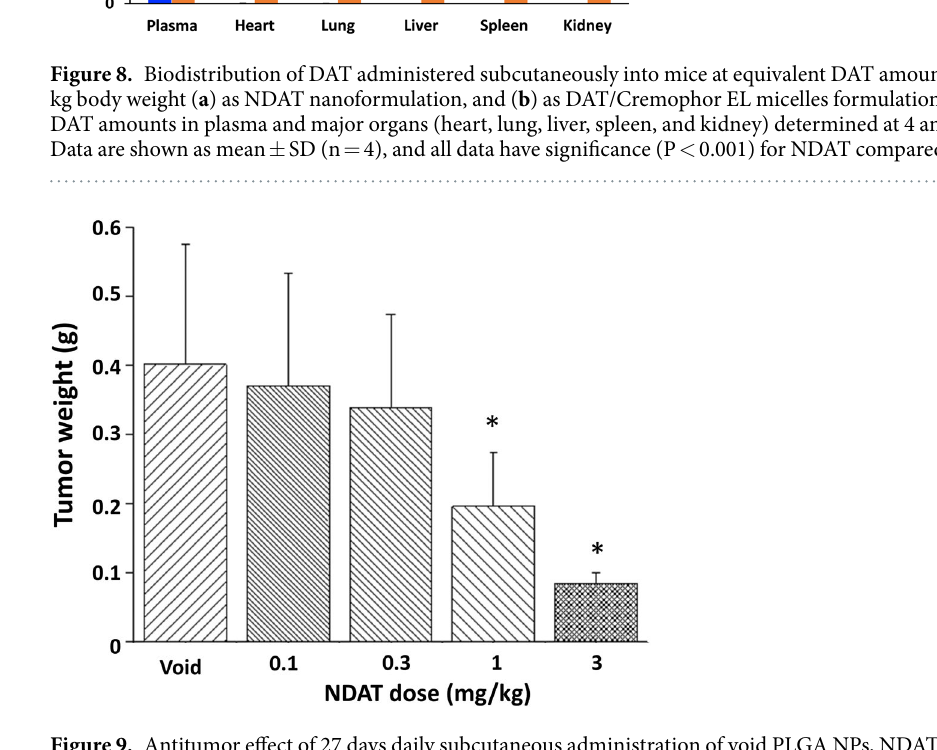
Figure 9. Antitumor effect of 27 days daily subcutaneous administration of void PLGA NPs, NDAT at equivalent DAT of 0.1, 0.3, 1, and 3 mg/kg body weight treatment on U87 glioblastoma xenograft weight. Data are shown as mean ± SD (n = 4). For 1 mg/kg dose, * P = 0.0187, for 3 mg.kg dose, * P =